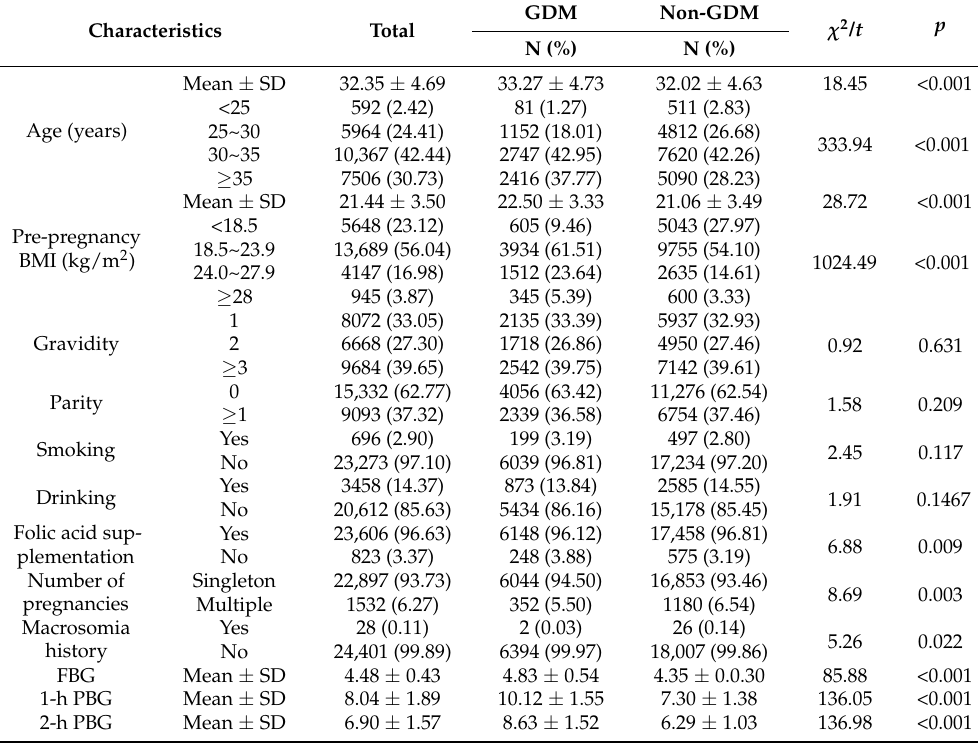
Table 1. Demographic characteristics of the study